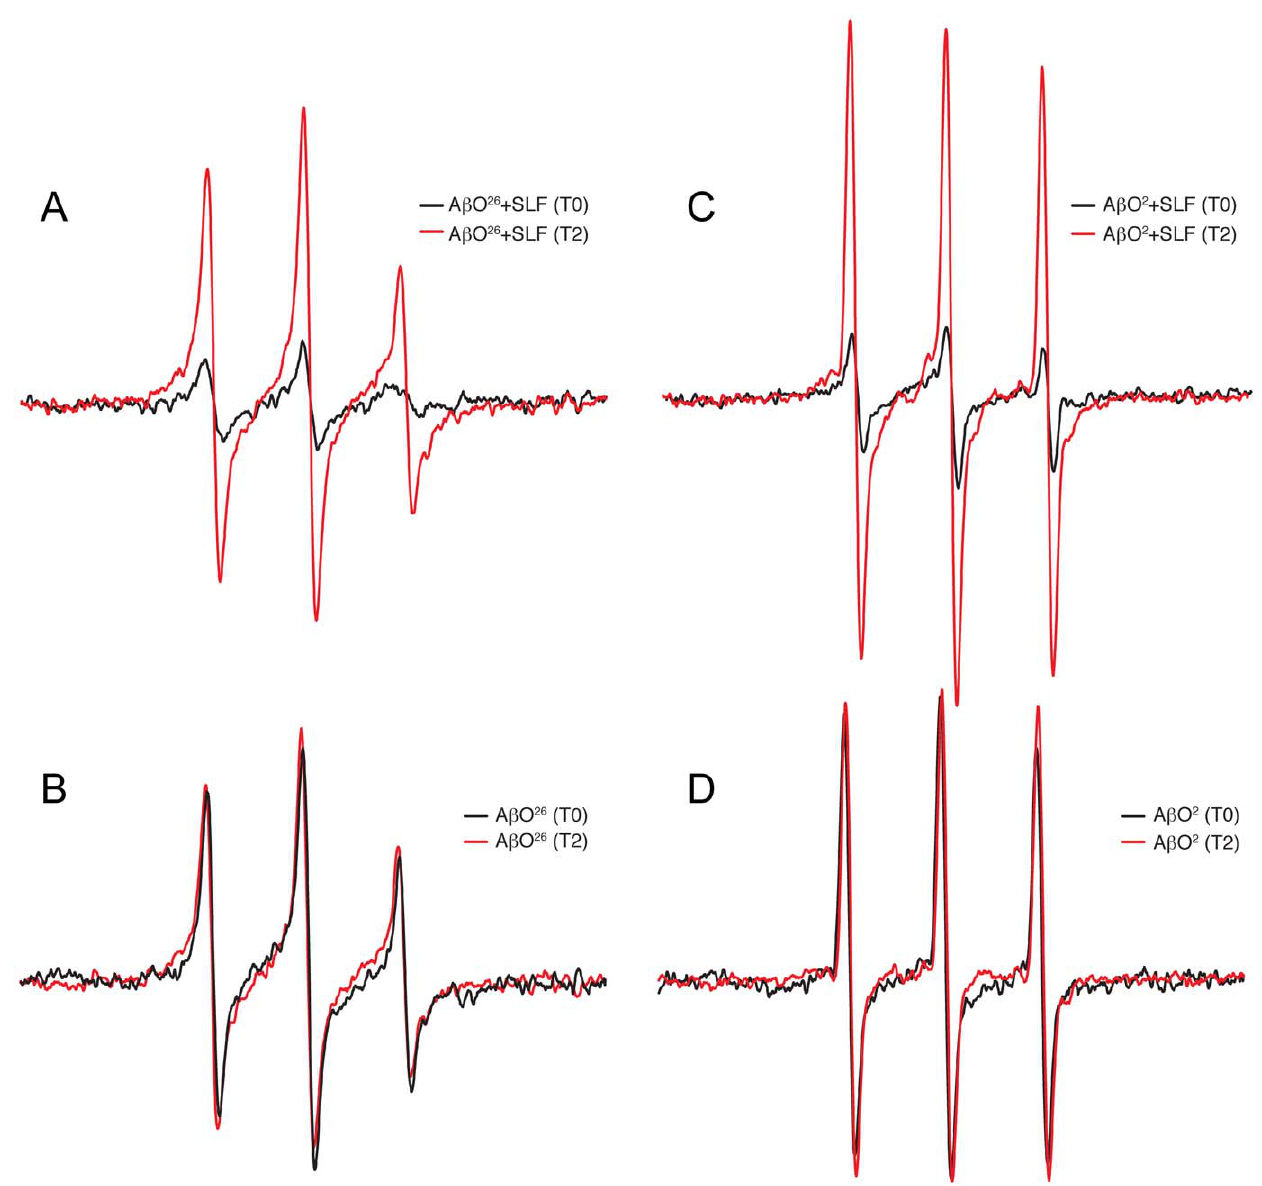
Figure 8. Fluorenes bind A b O and destabilize highly organized secondary structure. EPR spectra of SLF (10 m M) with single-cysteine mutant A b (1–40) oligomers (40 m M) show that motional freedom of the mixture increased following a 2-hour incubation at room temperature